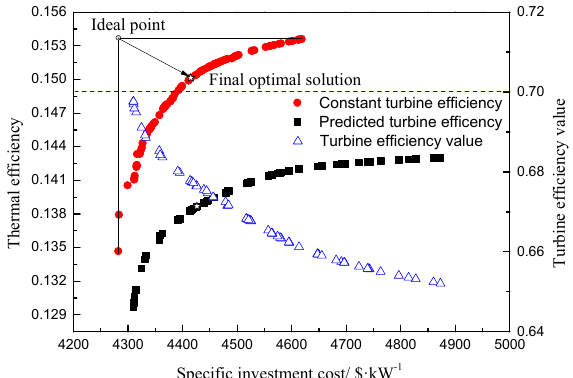
Figure 8. Pareto frontier of ORC CTE system and ORC DTE system.